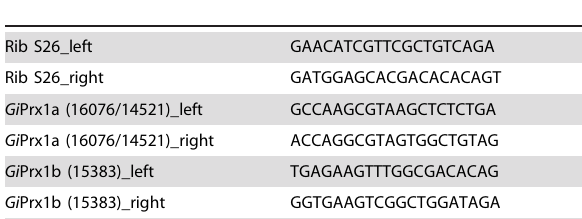
Table 1. Primers sequence (5 9 R 3 9 )